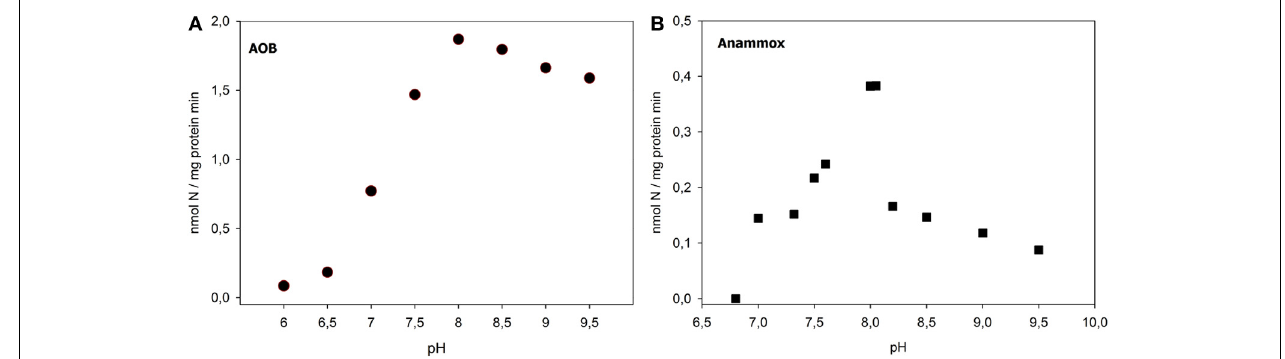
FIGURE 1 | pH effect on AOB (A) and anammox (B) activity in the nitritation-anammox